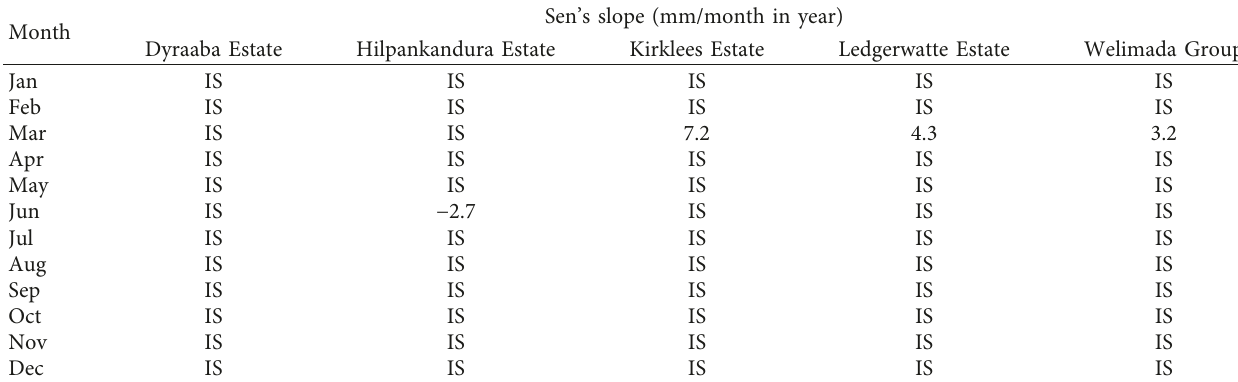
Figure 4: Rainfall variation for five rain gauges: (a) Dyraaba Estate. (b) Hilpankandura Estate. (c) Kirklees Estate. (d) Ledgerwatte Estate. (e) Welimada Group. Table 3: Trend analysis results on monthly